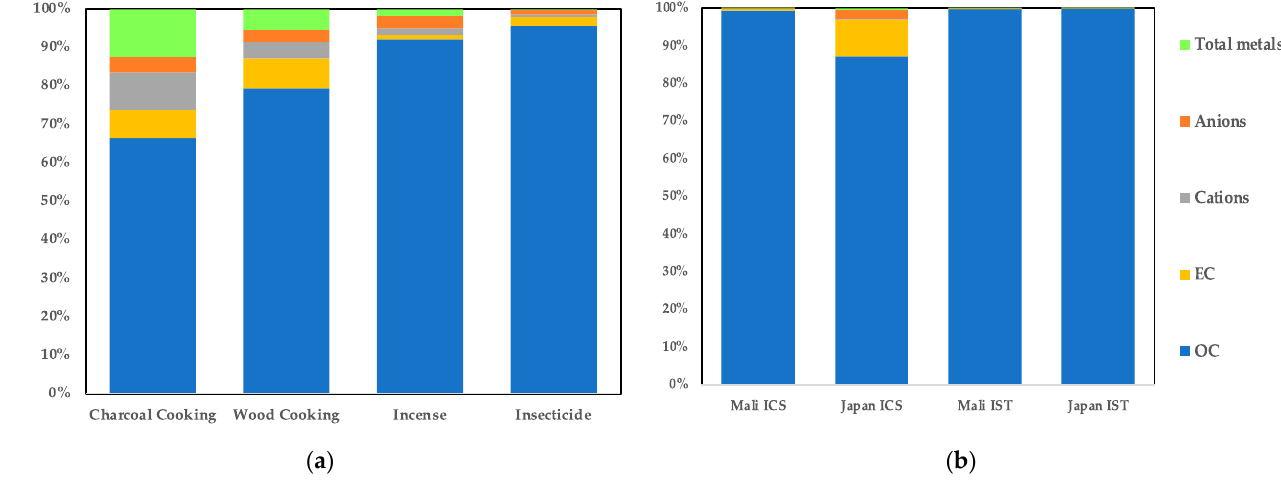
Figure 3. Contribution of particulate matter constituents in different samples. ( a ) in situ samples (N = 18); ( b ) laboratory samples (N = 22). ICS: incense; IST: insecticides.